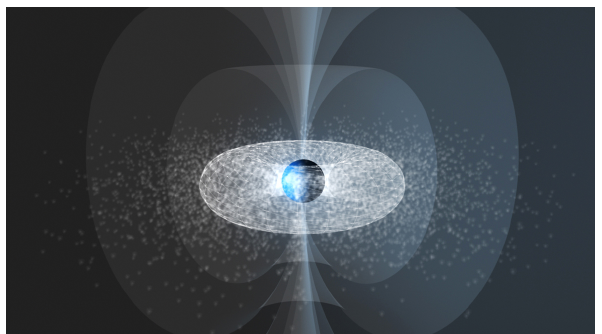
Figure 8. Artist’s impression of the plasmasphere, the innermost part of our planet’s magnetosphere. The white dots represent the plasmaspheric winds that transfer plasma from the plasmasphere into the magnetosphere at a rate of ∼ 5.10 26 ionss − 1 .